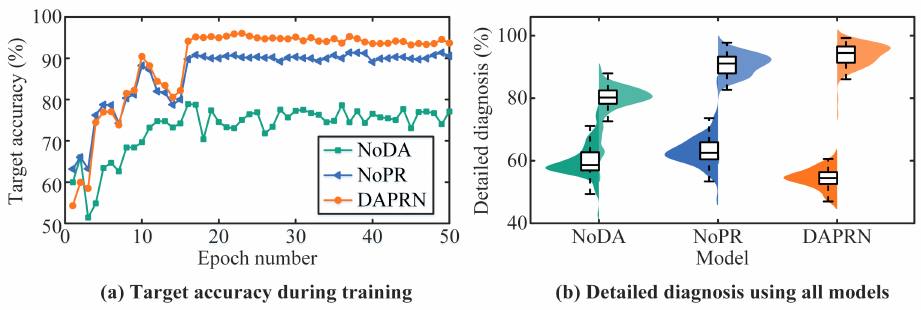
Figure 12. The training process of all models: ( a ) target accuracy during transductive training process; ( b ) detailed diagnosis of one episode: left (epoch = 1), right (epoch =